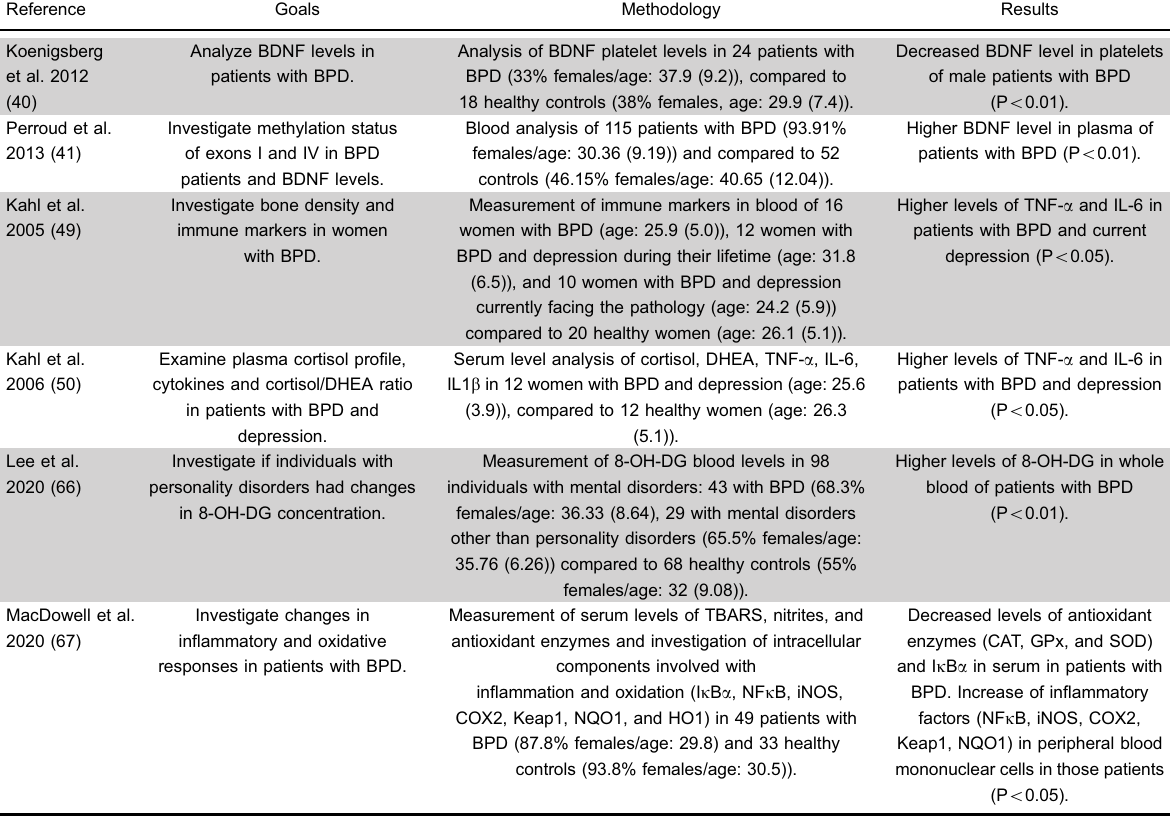
Table 1. List of studies that link borderline personality disorder (BPD) with neurotrophins, in fl ammatory cytokines, or oxidative stress. Reference Goals Methodology